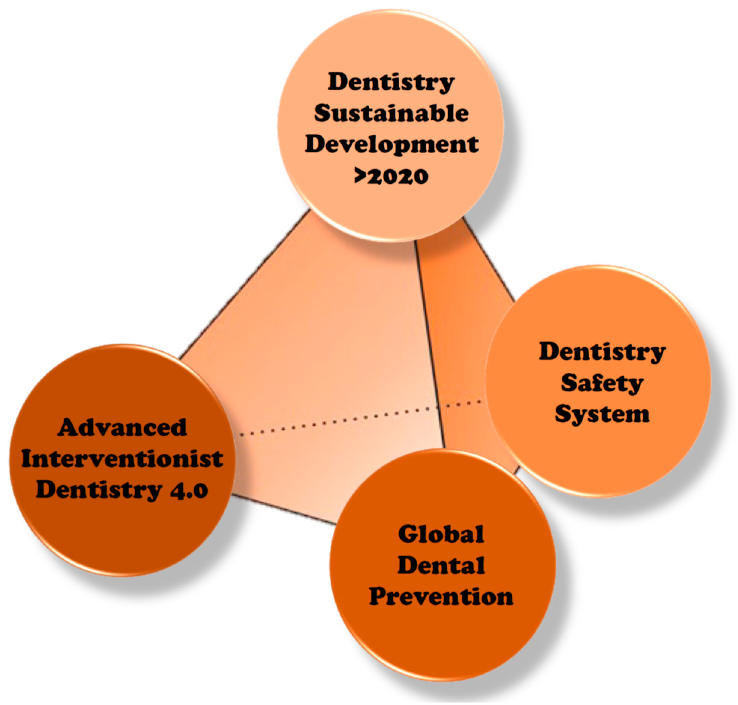
Figure 39. Model of the sustainable development of modern dentistry from 2020.